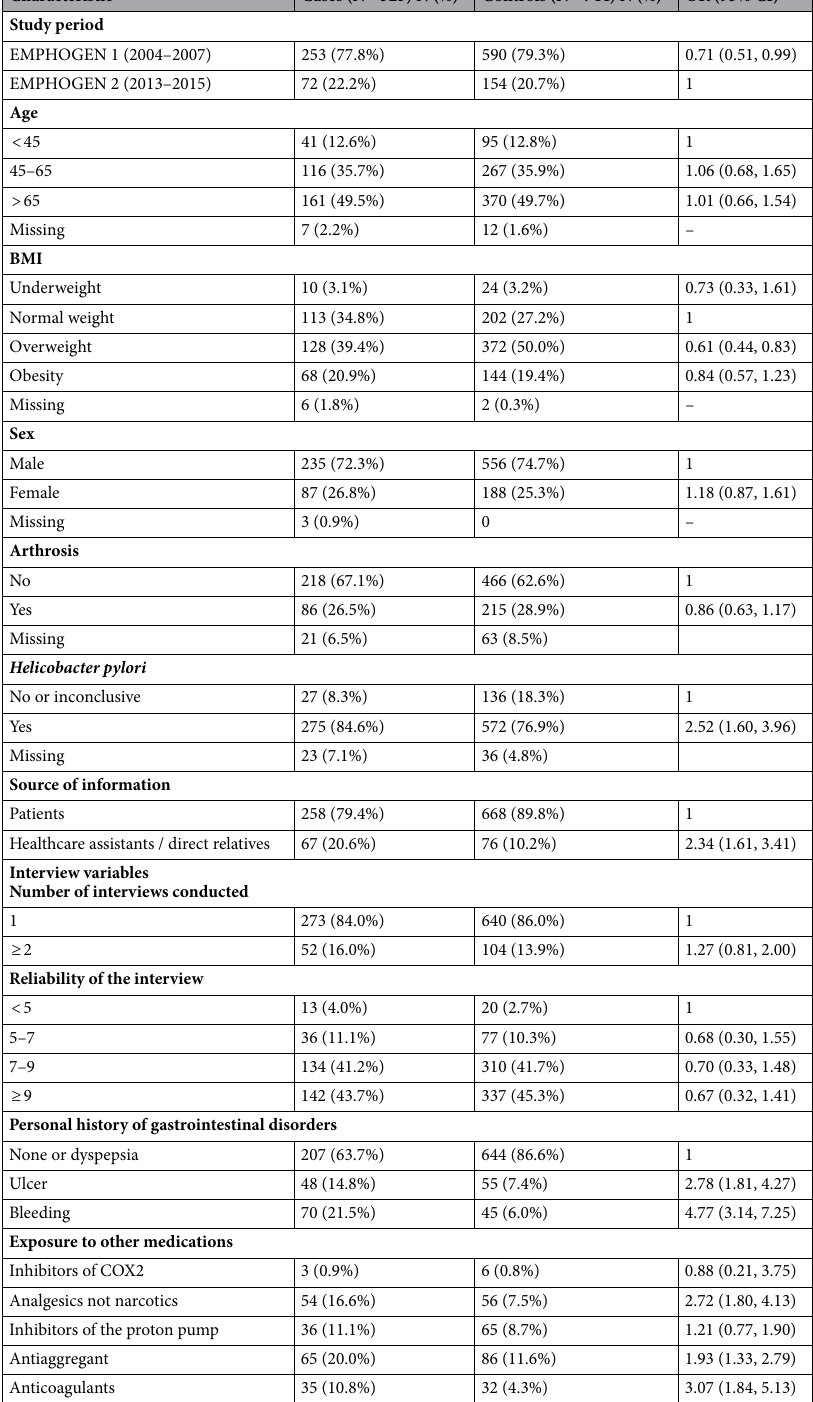
Table 1. Clinical and demographic characteristics of the study population . CI, confidence interval; N, number of participants; OR, odds